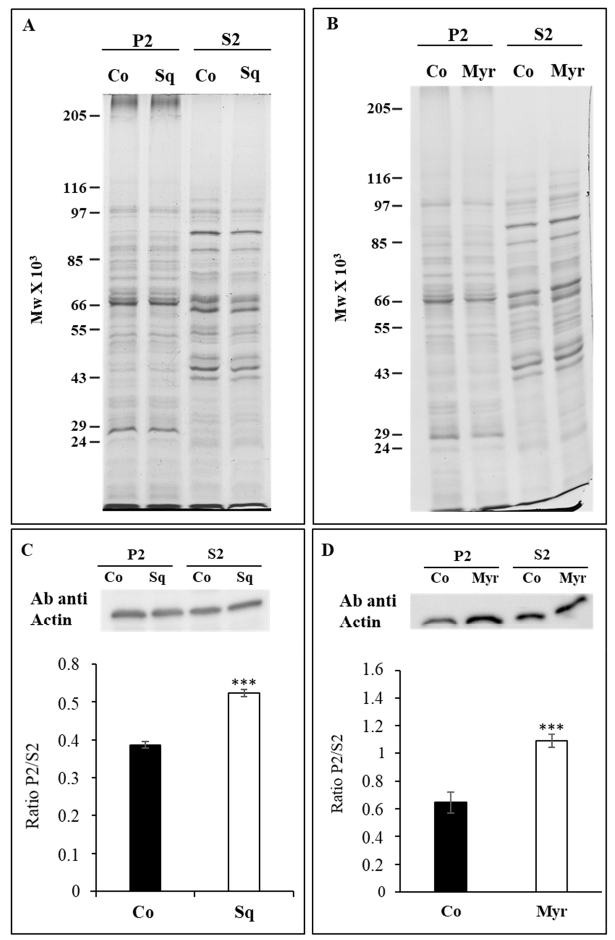
Figure 2. Effect of squalestatin and myriocin on actin partitioning between membranes (P2) and soluble fractions (S2). SDS-PAGE electrophoresis did not show significant differences in protein pattern between control and myriocin/squalestatin pollen tubes ( A , B ). However, Western blotting analysis, with an anti-actin monoclonal antibody, shows that squalestatin and myriocin significantly enhanced the interaction of actin with microsome (( C , D ); western and graph; ANOVA and Tukey’s post hoc test: p < 0.001 reported as ***). For quantification of protein level, the area of bands was considered in 5 independent experiments and statistical analysis was performed by ANOVA.